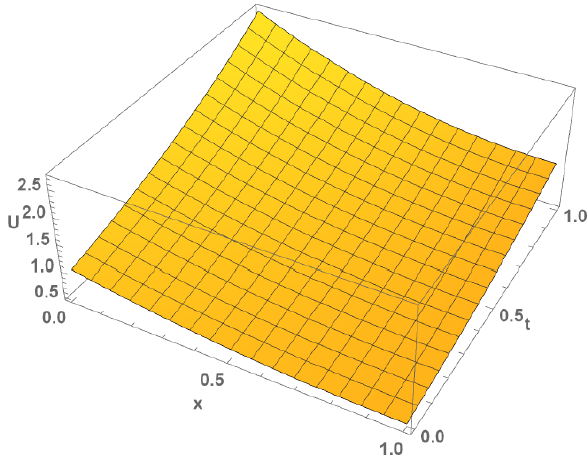
Fig. 2: Behavior of second term approximate solution U ( x , t ) w.r.t. x and t, when α = 1 for Eqs. (7)–(8).